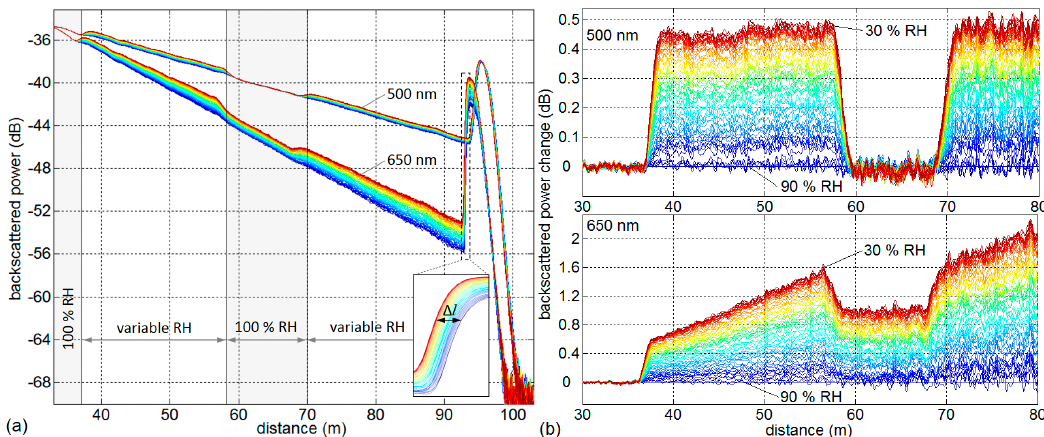
Figure 3. Multiple OTDR backscatter results at 500 nm and 650 nm during decreasing RH from 90% to 30% (from blue to red, compare Figures 5 and 6: data during the time period t = 17 d to t = 22 d): ( a ) OTDR backscatter traces and ( b ) backscattered power changes relative to l = 35 m and 90% RH.